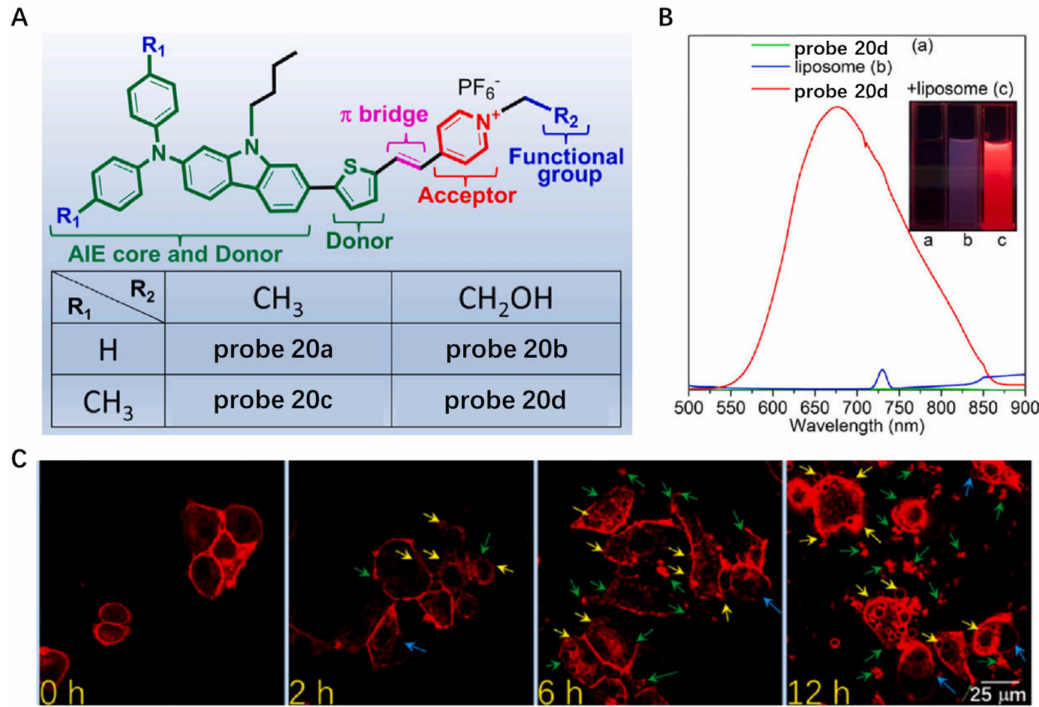
Figure 20. ( A ) Chemical structures of probe 20a – d . ( B ) The fluorescence spectra of probe 20d in the presence of liposome. ( C ) Realtime monitoring the CM damage using probe 20d . Scale bar: 25 µ m. Copyright 2023 Elsevier [79].